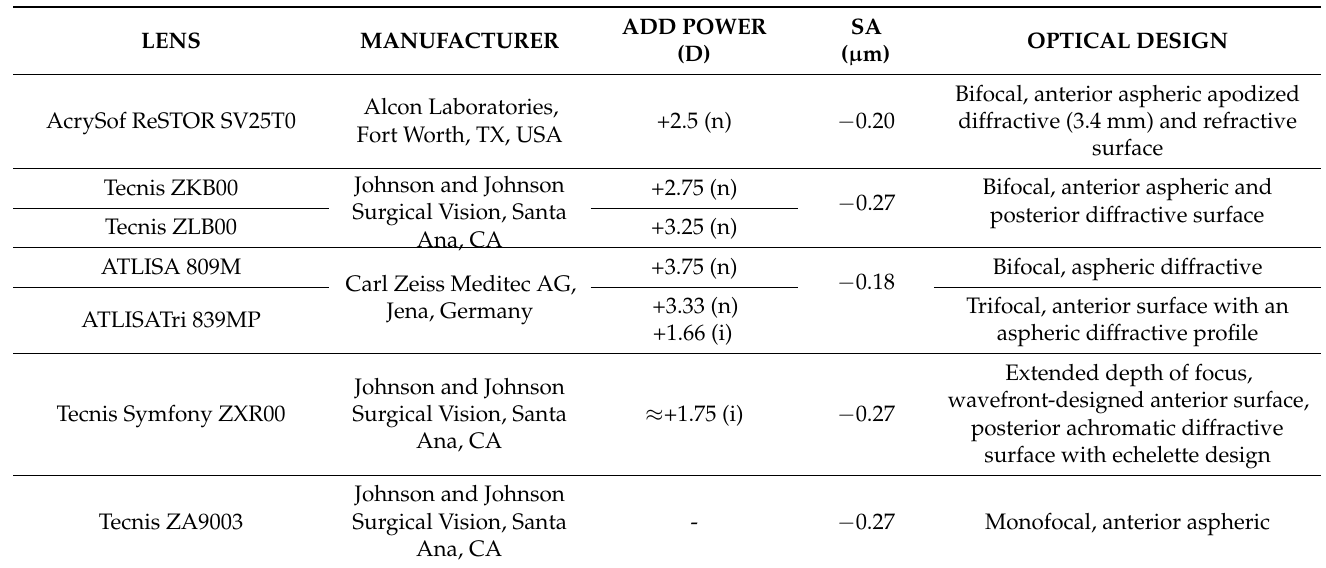
Table 1. Intraocular lenses used in the study, base power of 20.00 diopters (D). Near (n) and in- termediate (i) add powers correspond to the plane of the lens. Spherical aberration (SA) is for a 6.0 mm